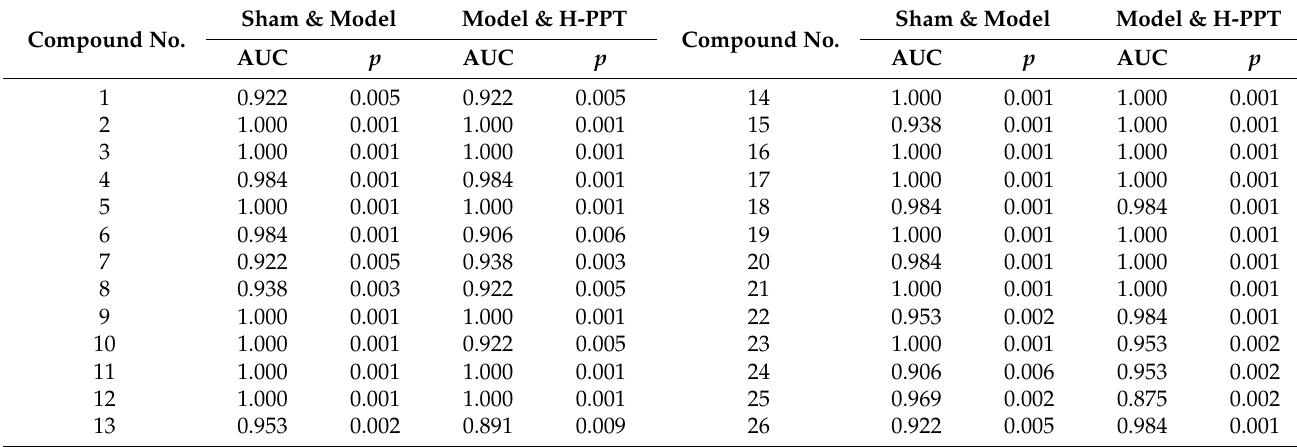
Table 2. The AUCs and p values of the biomarkers in different predictive ROC curves.